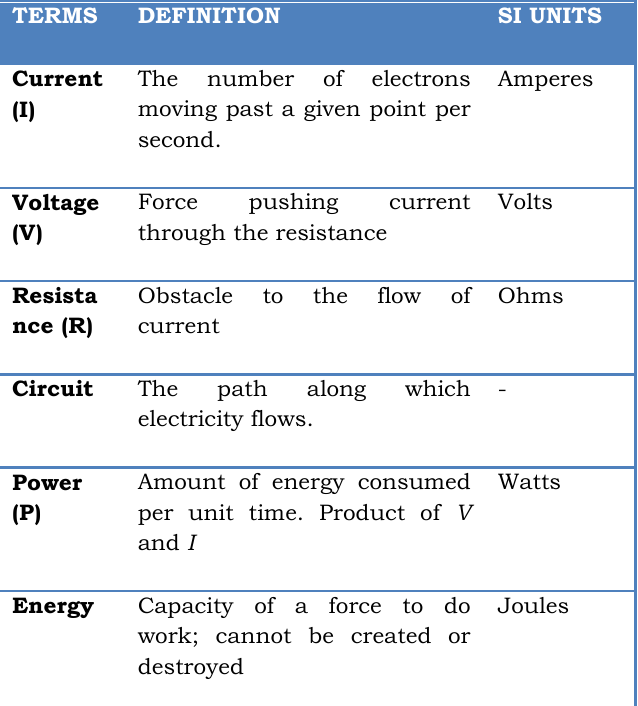
Table 1: Definitions of electrical